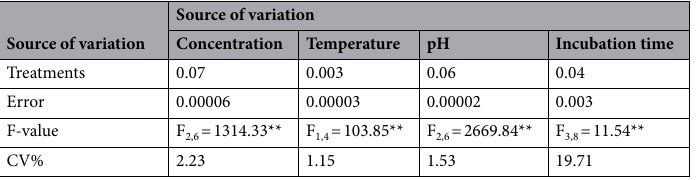
Table 1. Analysis of variance (ANOVA) of optimization process of AgNPs biosynthesis. **Significant at 5% probability